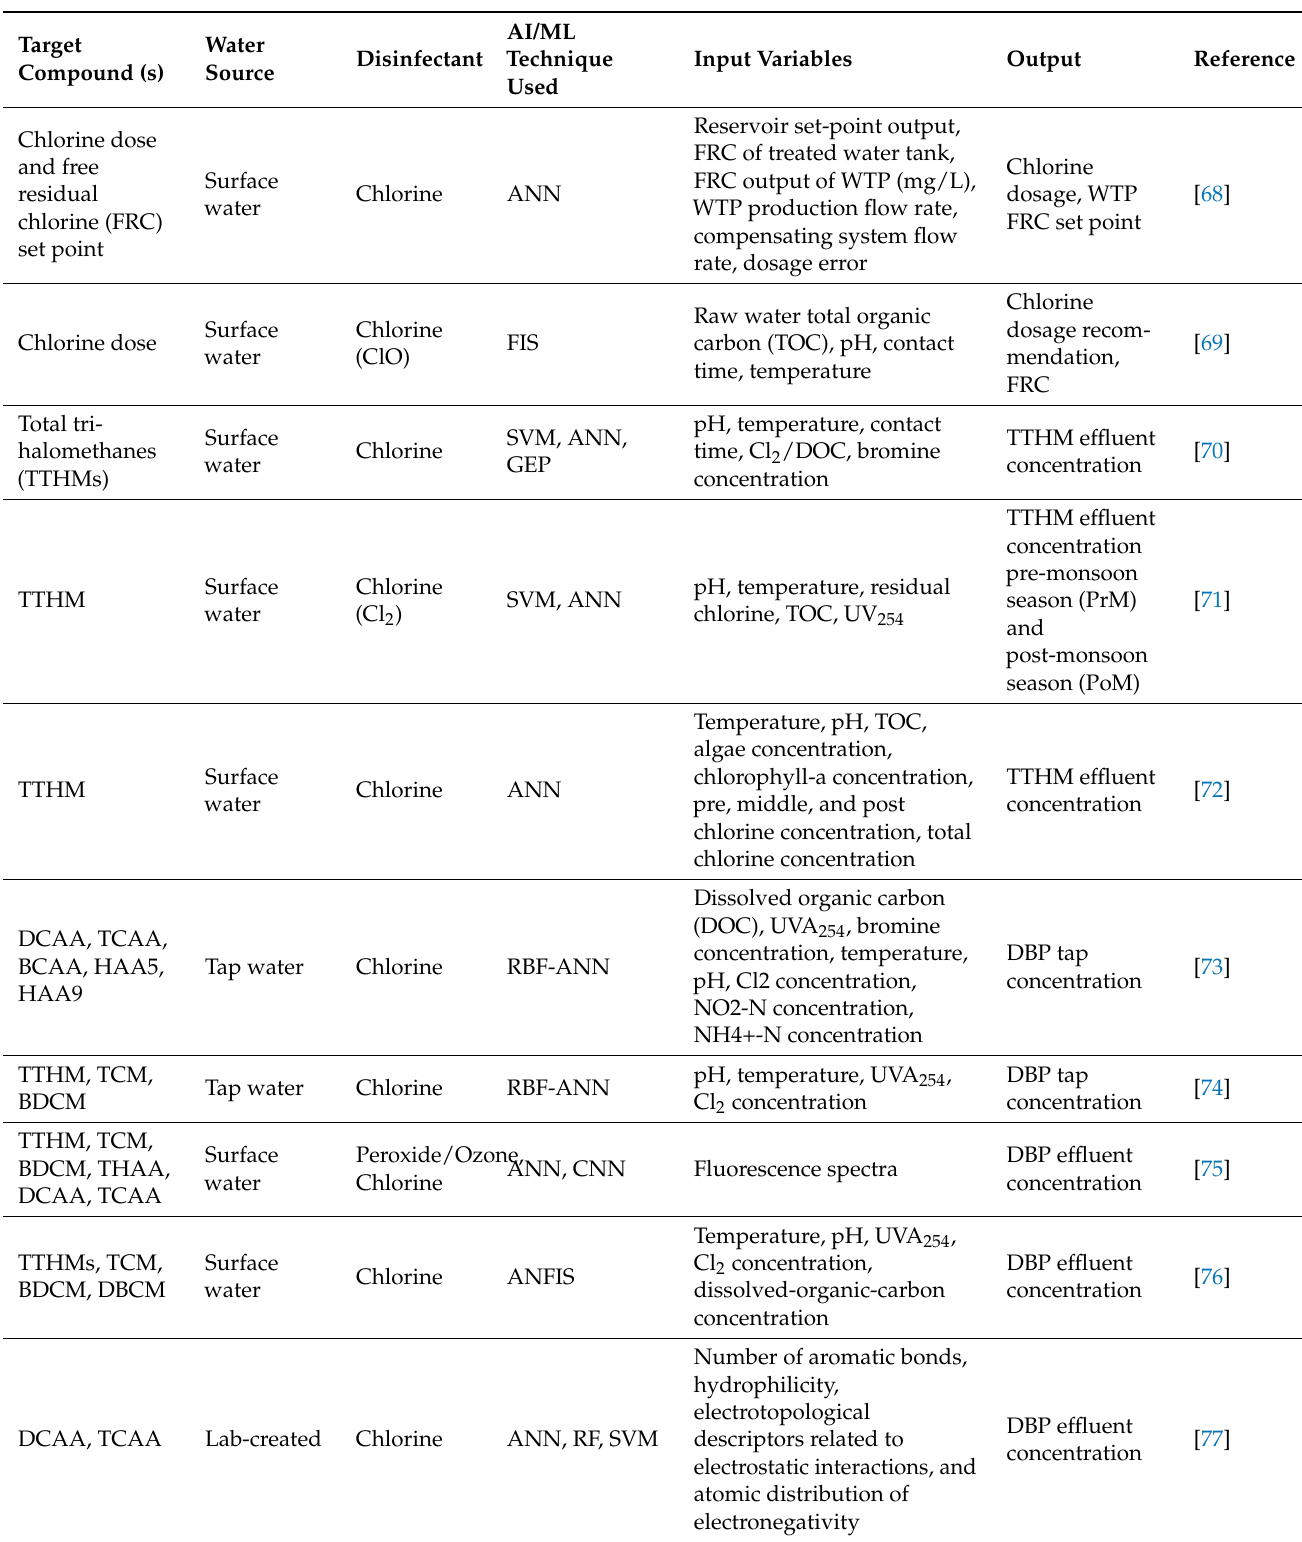
Table 2. AI methods to automate and ML to model and predict DBP formation/chlorine